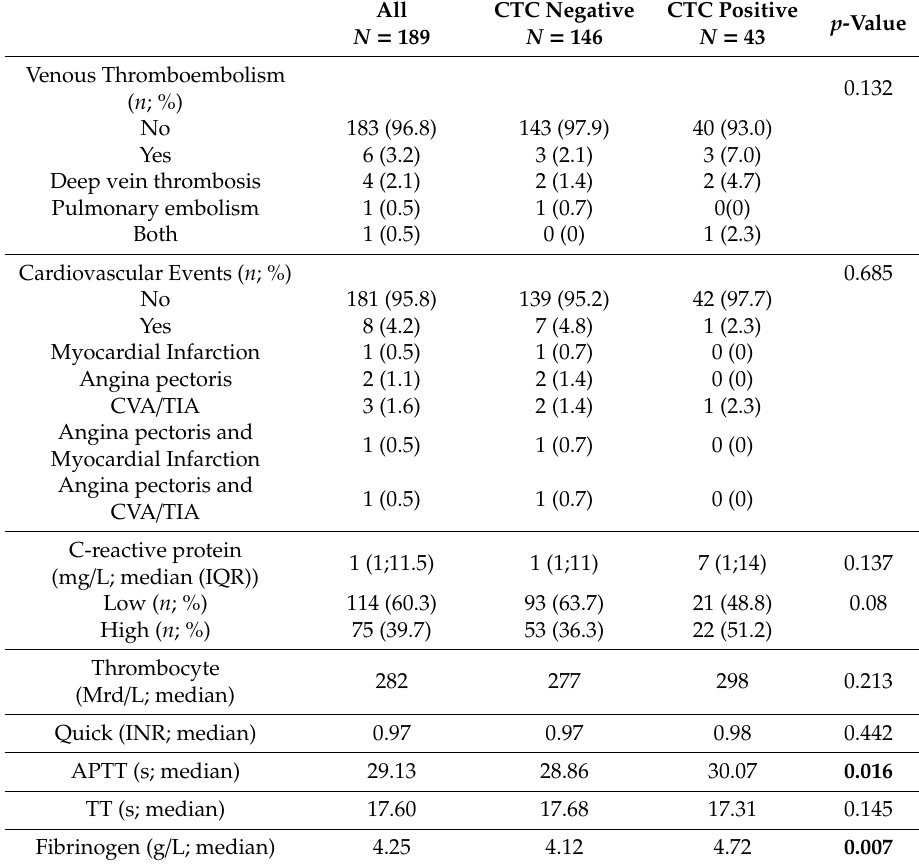
Table 2. Comparative analysis of venous thromboembolism, cardiovascular events, and laboratory index parameters of 189 UCB patients treated with radical cystectomy and bilateral lymphadenectomy stratified by CTC